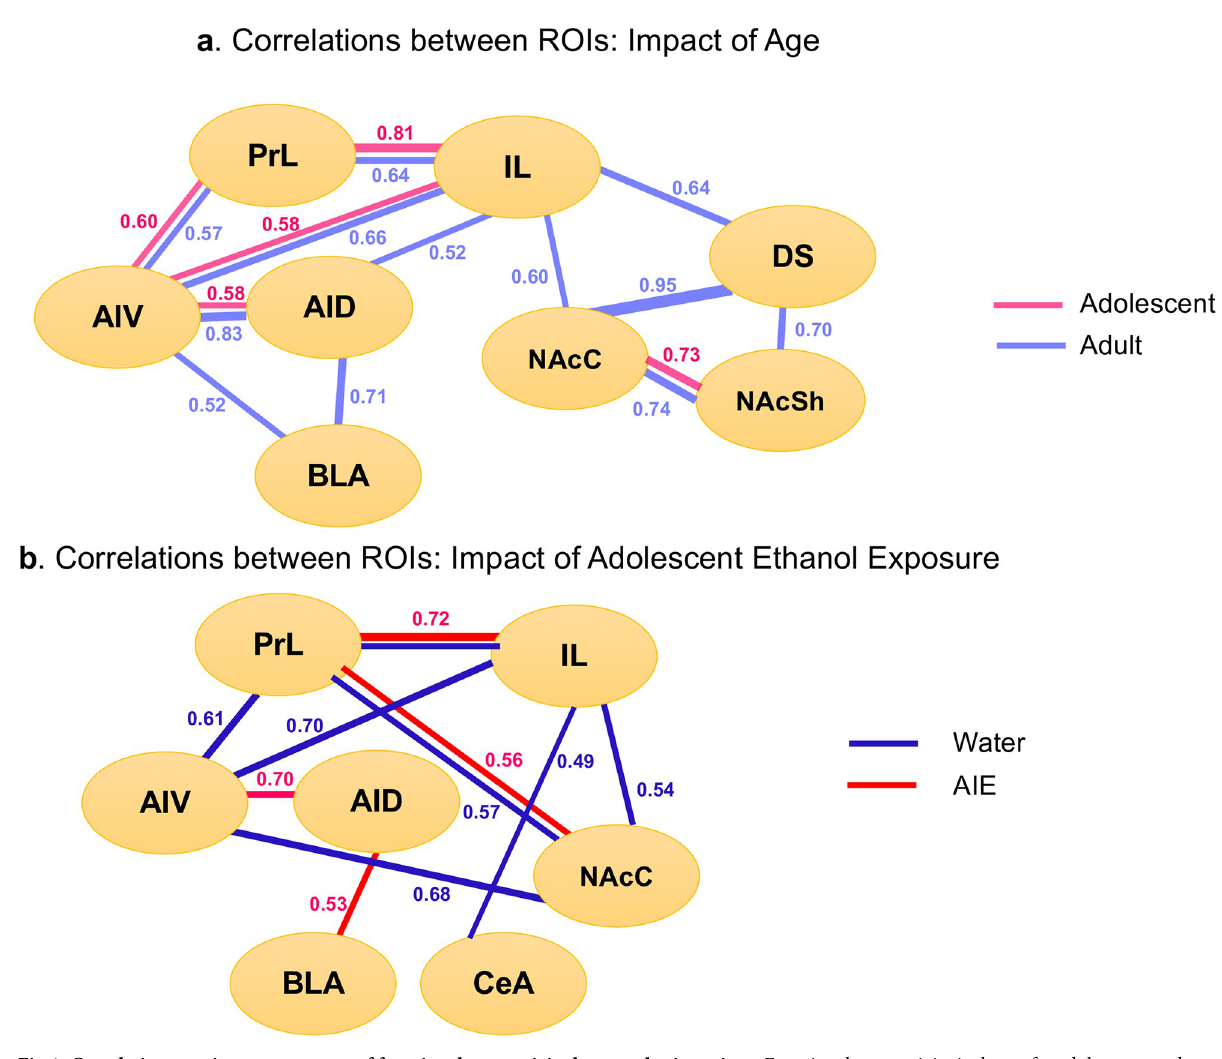
Fig 4. Correlation matrices as a measure of functional connectivity between brain regions. Functional connectivity is shown for adolescents and adults in Experiment 1 (a) and water and AIE exposed adults in Experiment 2 (b). Only significant (p < 0.05) correlations are presented, number represent r